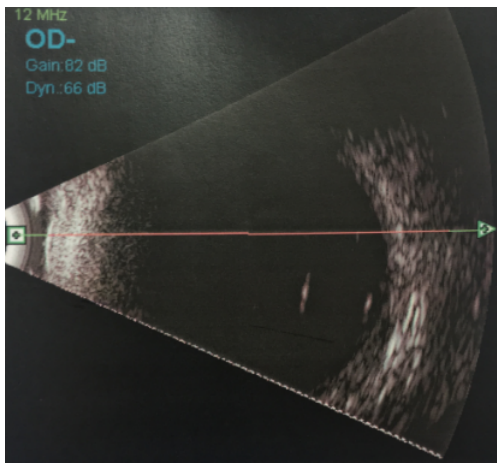
Figure 3: B-scan ultrasound of the right eye with vitreous opacity